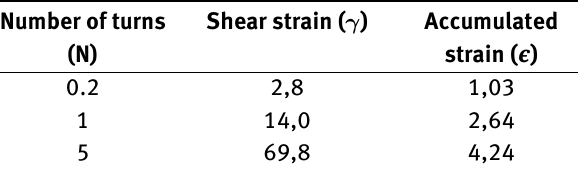
Table 1: Calculated shear strain and accumulated strain values for the different HPT deformed disks obtained at the perimeter (r=2mm) with a final thickness L=0.9